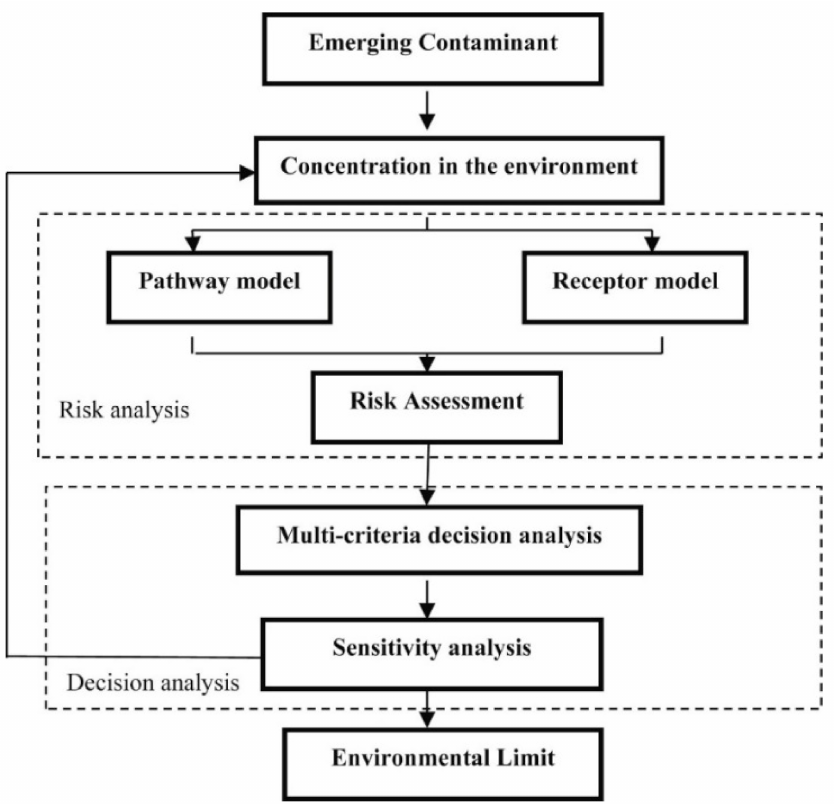
Figure 6. Risk-based decision analysis [62] (reproduced from [62] with Elsevier permission, license 4912101420021, from 18 September